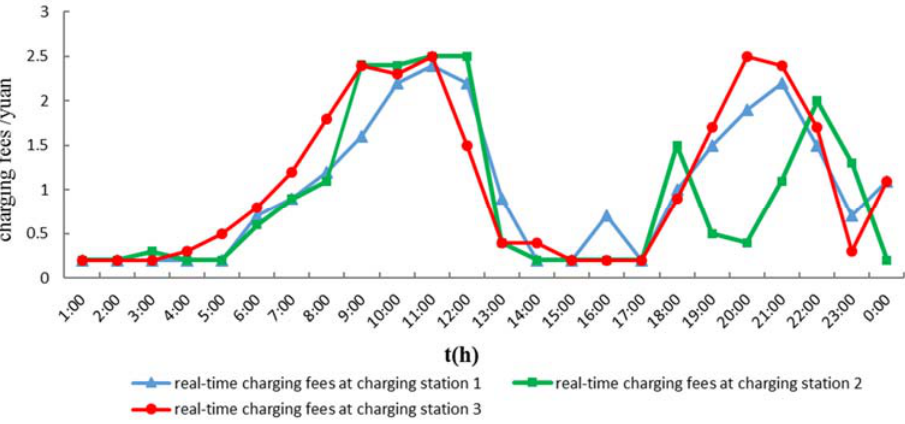
Figure 7. Real-time charging fees of each charging station.